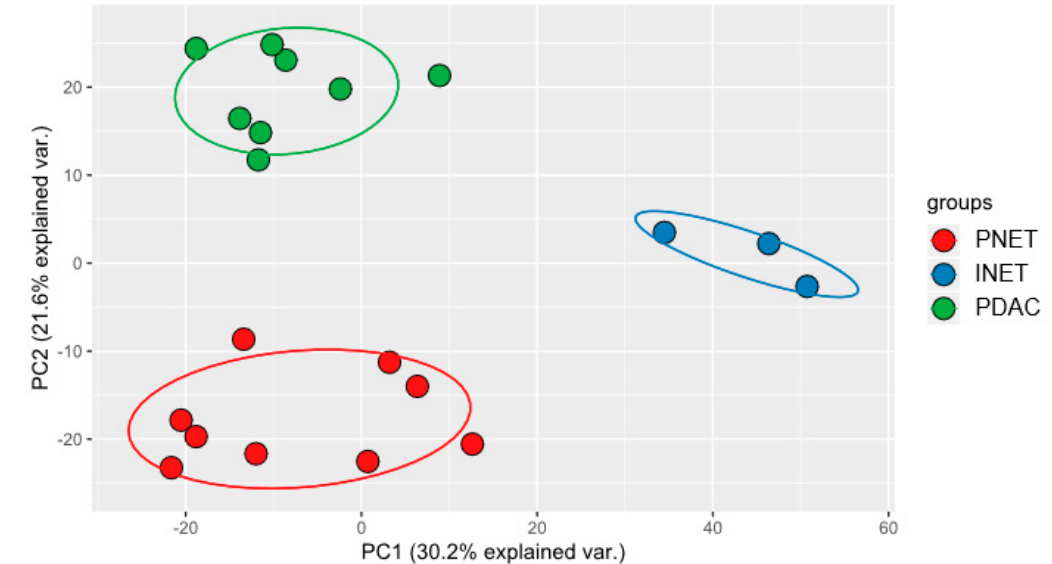
Figure 4. Deep sequencing of the miRNA transcriptomes identified 258, 297, and 129 mRNAs, whose expression significantly differentiated between PDACs and PNETs, PDACs and INETS, and PNETs and INETs, respectively, as demonstrated by principal component analysis (PCA) using the standard R programming language function “prcomp.”.